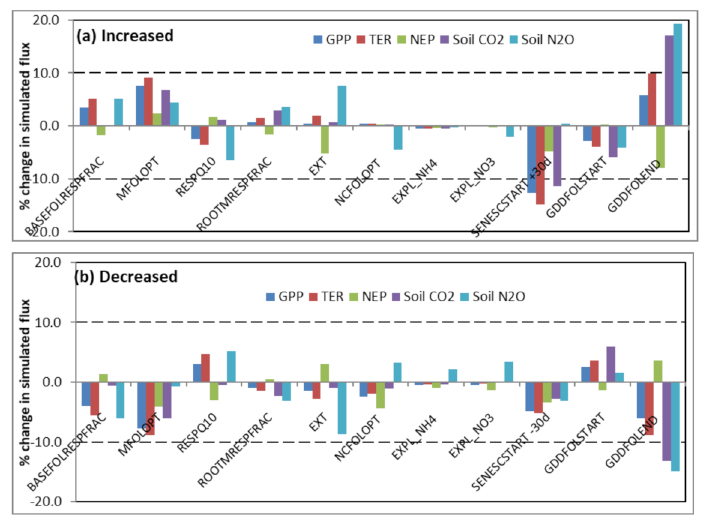
Figure 7. Sensitivity tests showing % change in simulated annual CO 2 and N 2 O fluxes with chosen PnET module parameter values ( a ) increased by 10% and ( b ) decreased by 10% (except SENESC- START: changed by 30 days).